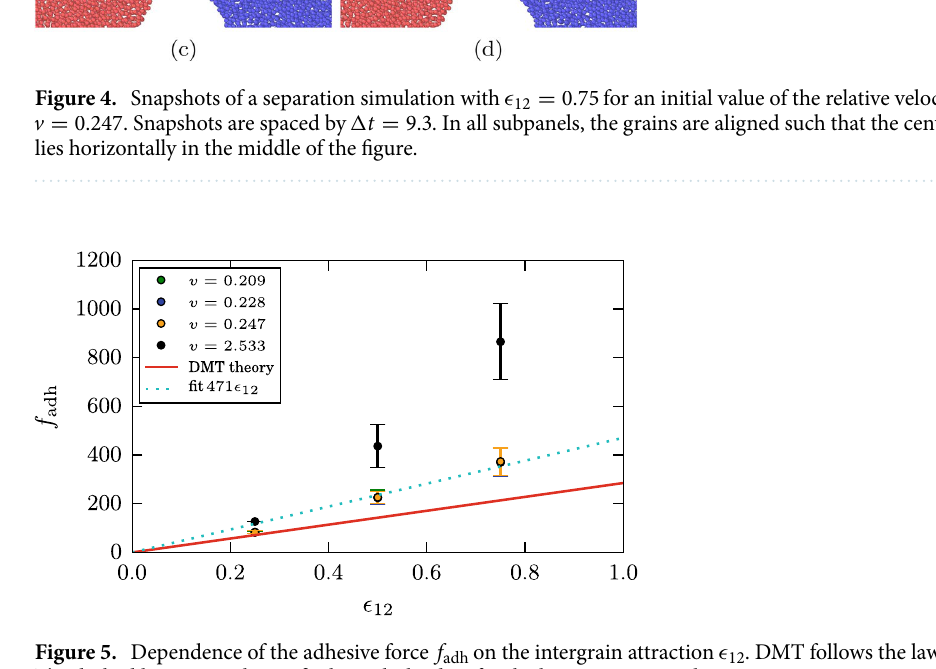
Figure 5. Dependence of the adhesive force f adh on the intergrain attraction ǫ 12 . DMT follows the law Eq. (3). The dashed line gives a linear fit through the data for the low separation velocities v